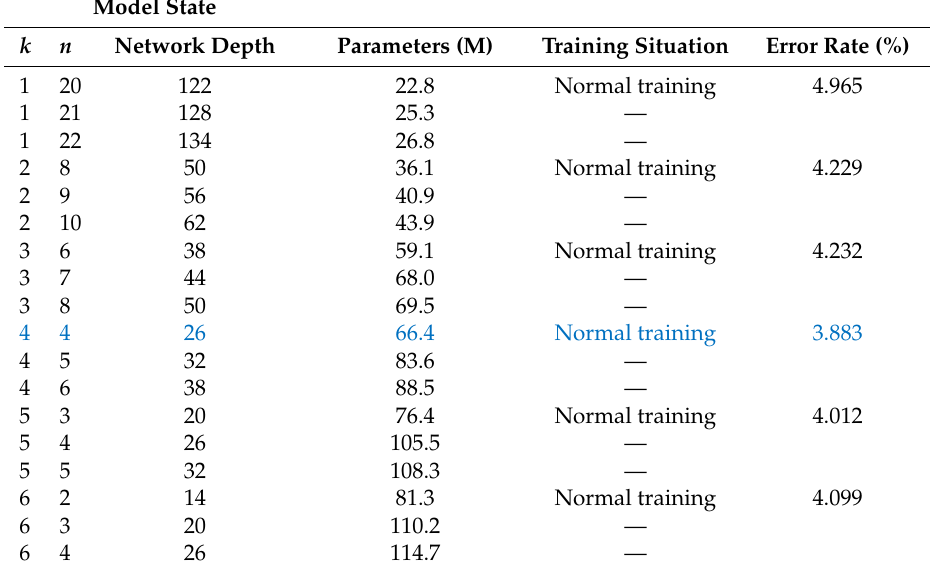
Table 4. The running state of model under different scaling parameters and network depths, where “—” indicates that GPU resources were exhausted and could not be trained (blue font indicates the